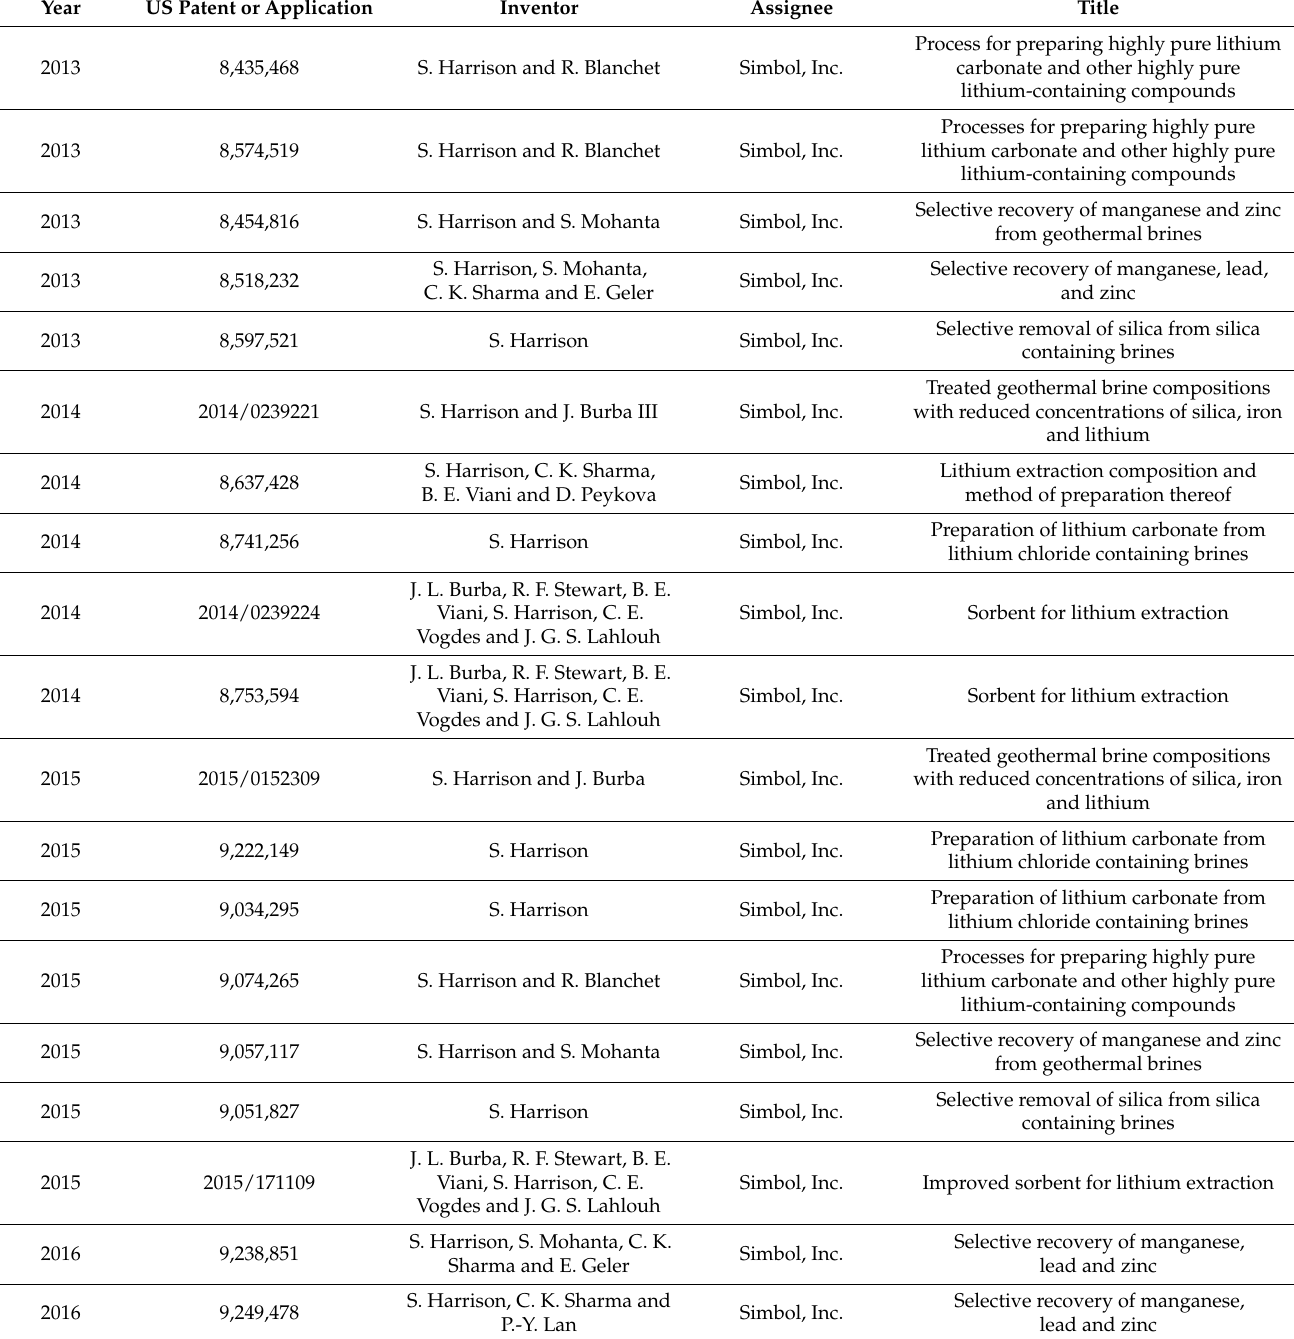
Table 7. Patents associated with Simbol Technology or S.